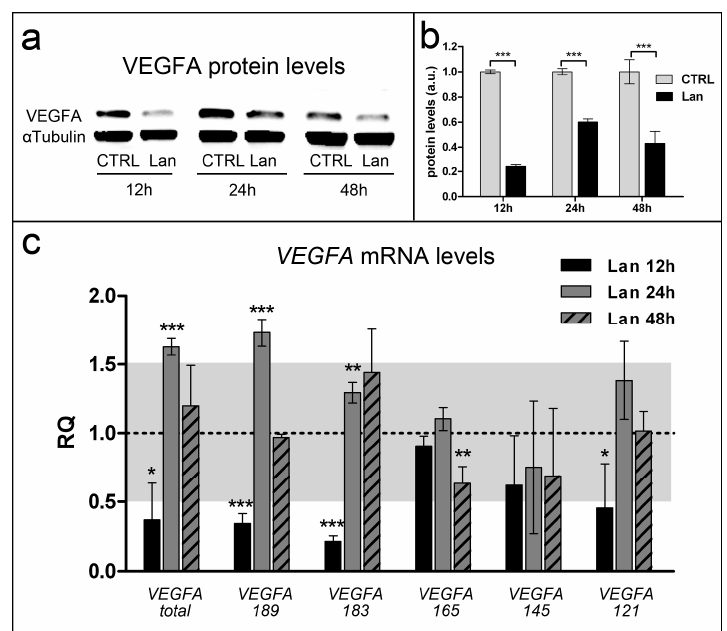
Figure 4. Molecular characterization of intracellular VEGFA levels in endothelial cells after 0.3 μ M lanthionine treatment in 12 h, 24 h and 48 h. ( a ) Western blot analysis of VEGFA protein abundance in endothelial cells; α Tubulin is the loading control; ( b ) relative differences in protein levels shown in ( a ) were quantitated by using ImageJ software, normalized to α Tubulin levels and expressed as arbitrary units (a.u.). ( c ) Relative quantitation (RQ) of the expression levels of VEGFA isoform transcripts (total VEGFA includes all isoforms, VEGFA-121, -145, -165, -183, -189), using qPCR method, in comparison to the untreated control shown as a dashed baseline and made equal to 1. Alterations of mRNA levels, which are being considered physiological with respect to the control, fall within the gray area between 0.5 and 1.5 RQ. The columns in b and c represent the mean and error bars indicate the SD from three independent experiments; p value versus untreated control = * p < 0.05, ** p < 0.01; *** p < 0.001, (according to Student’s t -test). CTRL, control; Lan, lanthionine; VEGFA, vascular endothelial growth factor A.